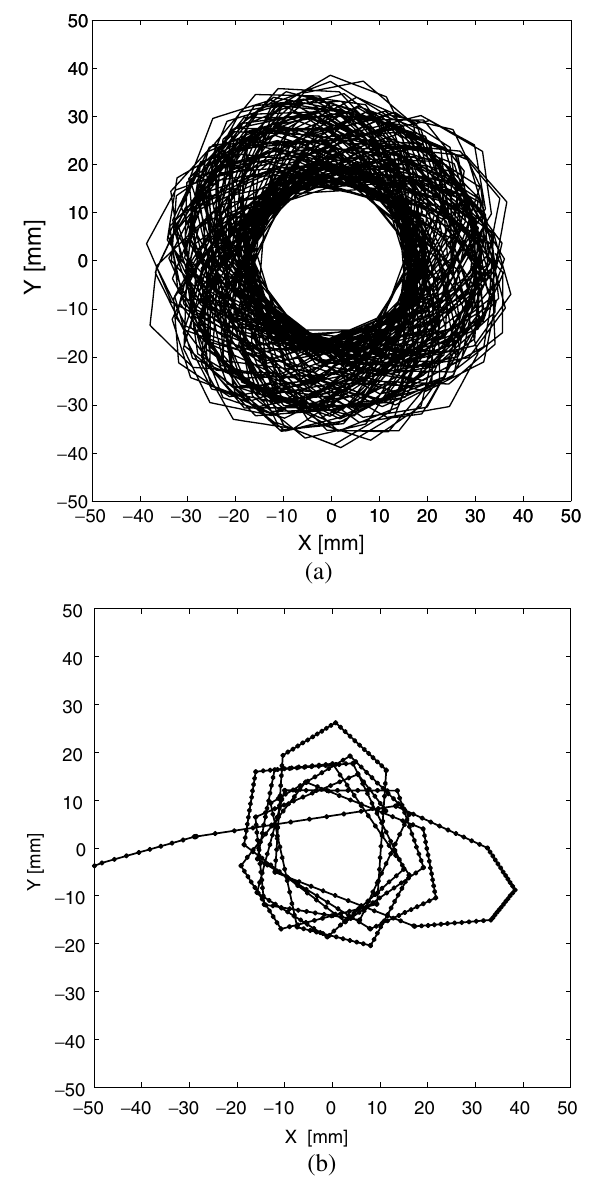
FIG. 11. Orbits of trapped electrons without magnetic field. (a) Long time trapped electron; (b) short time trapped